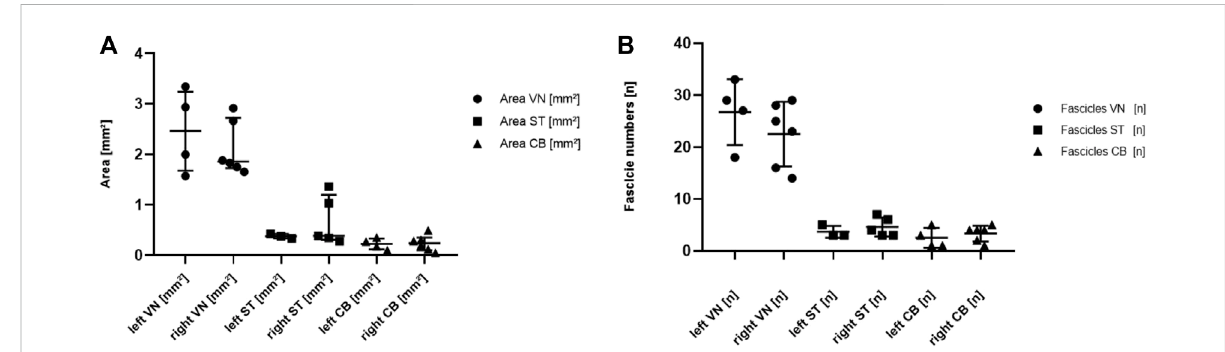
FIGURE 7 (A) . Comparison of the nerve area between VN, ST, and CB at the level of the cardiac branching point. Each dot represents one nerve. Data are represented as median and interquartile range. VN, vagus nerve; ST, sympathetic trunk; CB, cardiac branch. (B) .Comparison of the fascicle numbers intheVN, ST,andCB atthelevelofthecardiac branching pointfor theleft(leftcolumns)andtheright(right columns)sides.Each dotrepresents one nerve. Data are represented as median and interquartile range. VN, vagus nerve; ST, sympathetic trunk; CB, cardiac